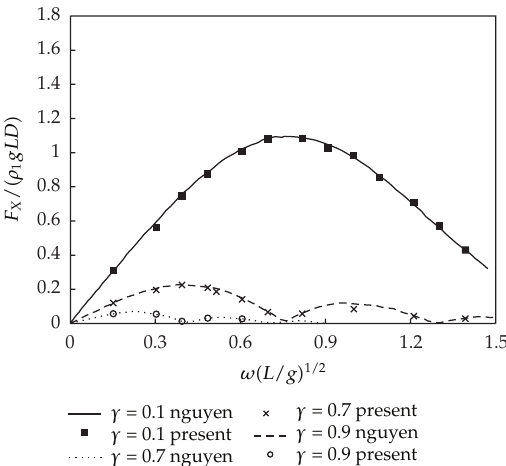
Figure 9: Horizontal wave force on box.